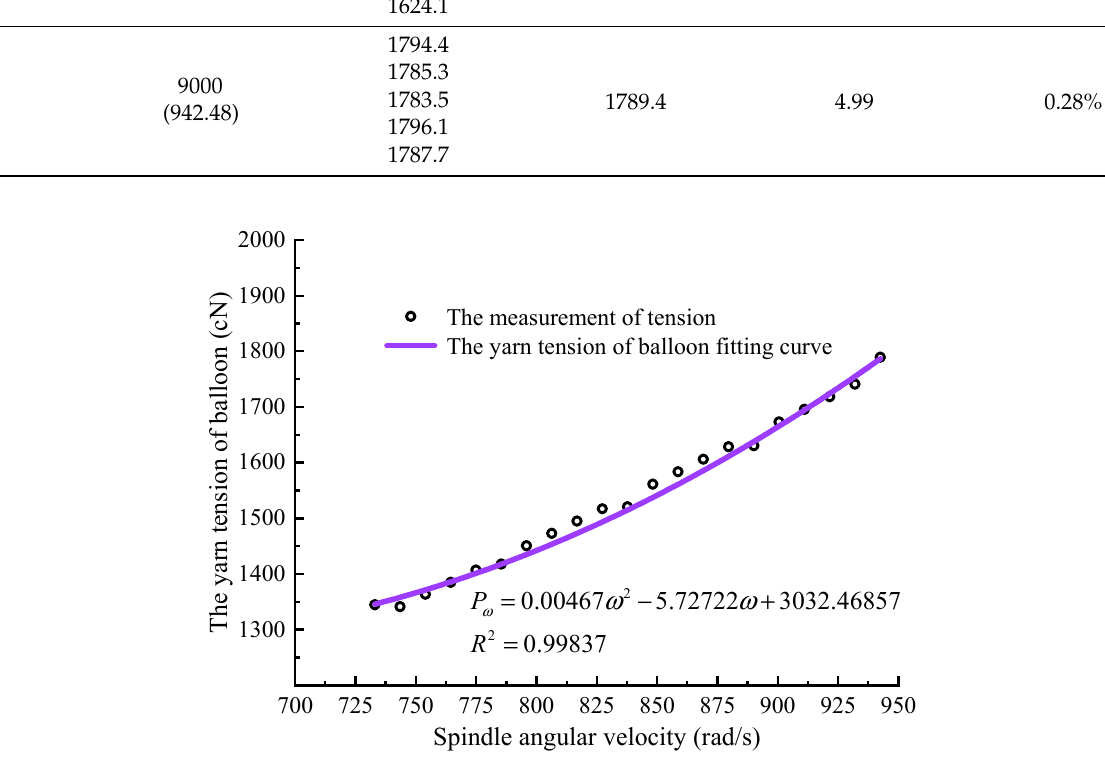
Figure 6. Tension–spindle angular velocity fitting curve for 1440 dtex.